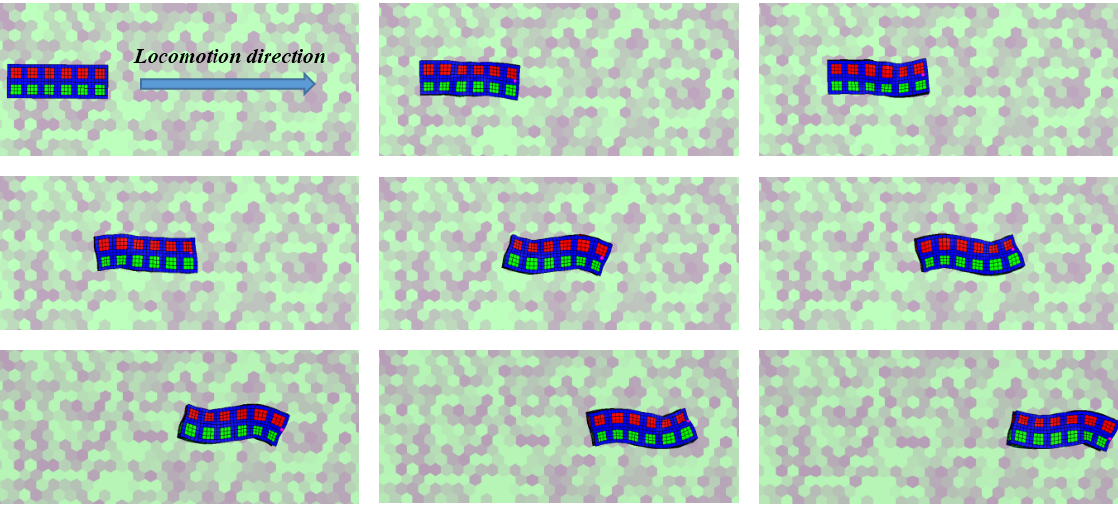
Figure 11. Locomotion Process of worm configuration in the real environment.